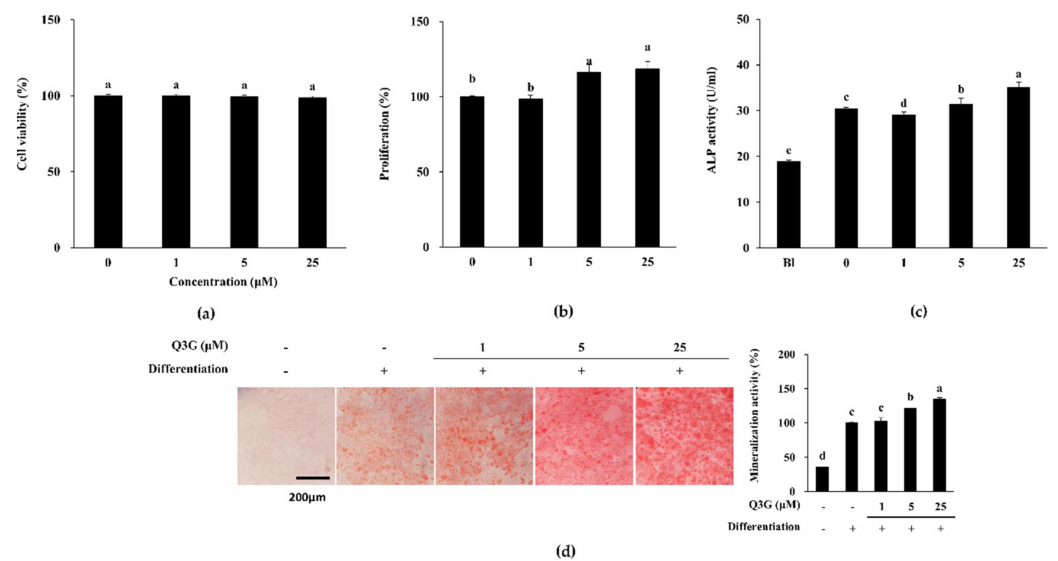
Figure 2. E ff ect of Q3G on the osteoblastogenic di ff erentiation of hBM-MSCs. ( a ) E ff ect of Q3G on on the viability of non-induced human bone marrow-derived mesenchymal stromal cells (hBM-MSCs). Viability of the cells was measured by quantification of MTT dye removed from cells after 48 h of treatment. Cell viability is given as relative percentage of untreated control. ( b ) E ff ect of Q3G on the proliferation of osteo-induced hBM-MSCs. Viable cell amount was measured by quantification of MTT dye removed from cells at day 3 of di ff erentiation. Proliferation was given as relative viable cell amount (%) of untreated osteo-induced control. ( c ) E ff ect of Q3G on the activity of cellular alkaline phosphatase (ALP). Cellular ALP activity of osteo-induced hBM-MSCs was measured with a spectrophotometric enzymatic activity assay at day 7 of di ff erentiation. Q3G was present in the first 3 days of di ff erentiation only. ( d ) E ff ect of Q3G on the extracellular mineralization of osteo-induced hBM-MSCs. Extracellular mineralization was measured by Alizarin Red staining and quantified by the absorbance values of the retained dye at day 10 of di ff erentiation. Mineralization was given as a relative percentage of untreated osteo-induced hBM-MSCs. Q3G was treated in the first 3 days of di ff erentiation only. Di ff erent letters (a–e) indicate statistically significant di ff erence ( p < 0.05) among